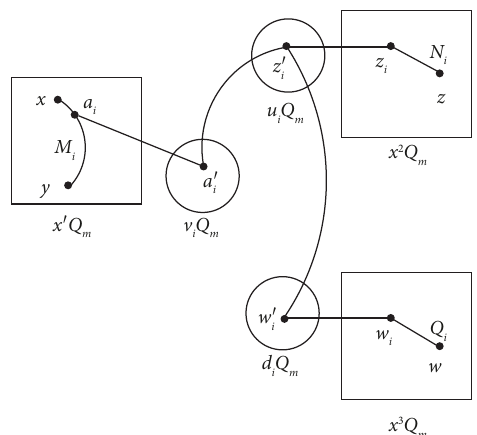
Figure 14: Te illustration of case 3 of Teorem Figure 13. Case 3 . x, y, z, w are distributed in three clusters.